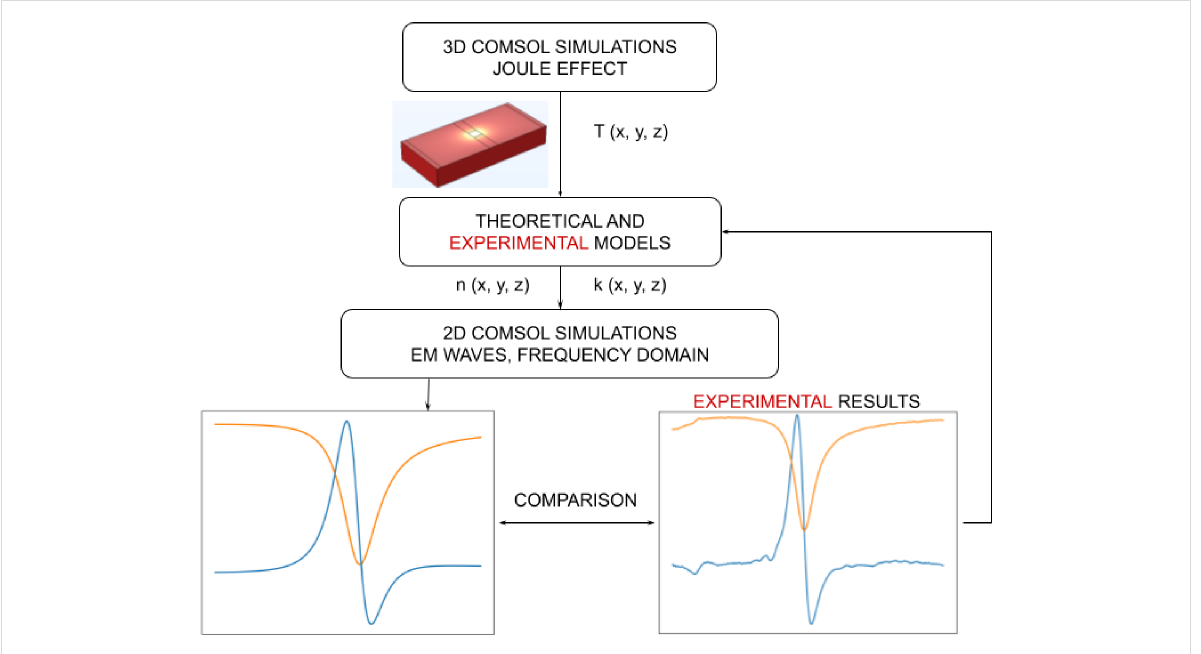
Figure 4: Flow diagram of simulation process.